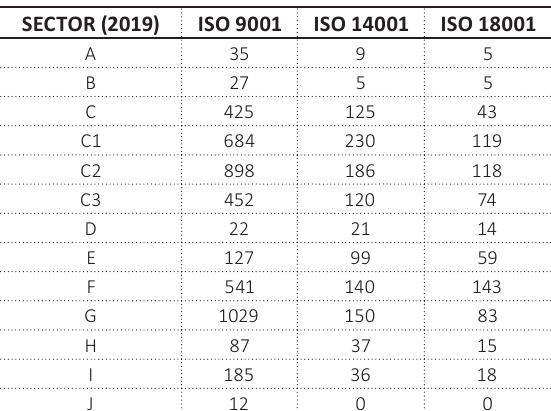
Table 2. Sectors of activity